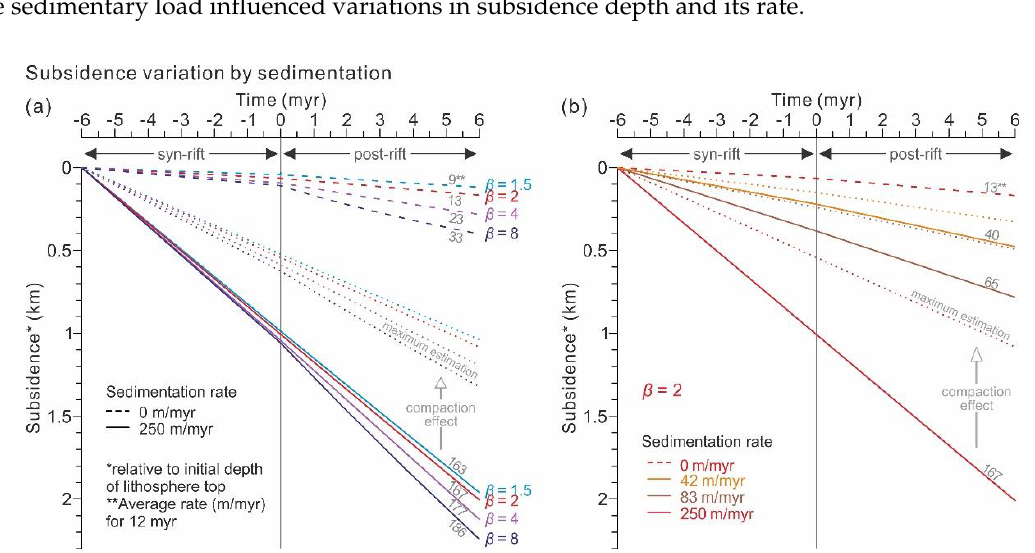
Figure 5. Subsidence depth and rate variation by sedimentation. Negative and positive values on the time axis indicate the syn-rift and post-rift phases, respectively; each phase duration is 6 myr in the model. The subsidence depth is relative to the initial depth of the lithosphere top. ( a ) Subsidence models, applying 𝛽 = 1.5, 2, 4, and 8. The dashed and solid lines are calculated with sedimentation rates of 0 and 250 m/myr, respectively. ( b ) Subsidence models of 𝛽 = 2, applying sedimentation rates of 0, 42, 83, and 250 m/myr (total stacked sediment layers of 0, 500, 1000, and 3000 m thickness, respectively). Averaged subsidence rates during 12 myr are shown (grey numbers). Dotted lines present the subsidence curves estimated with a maximum sedimentary compaction of ~50%.